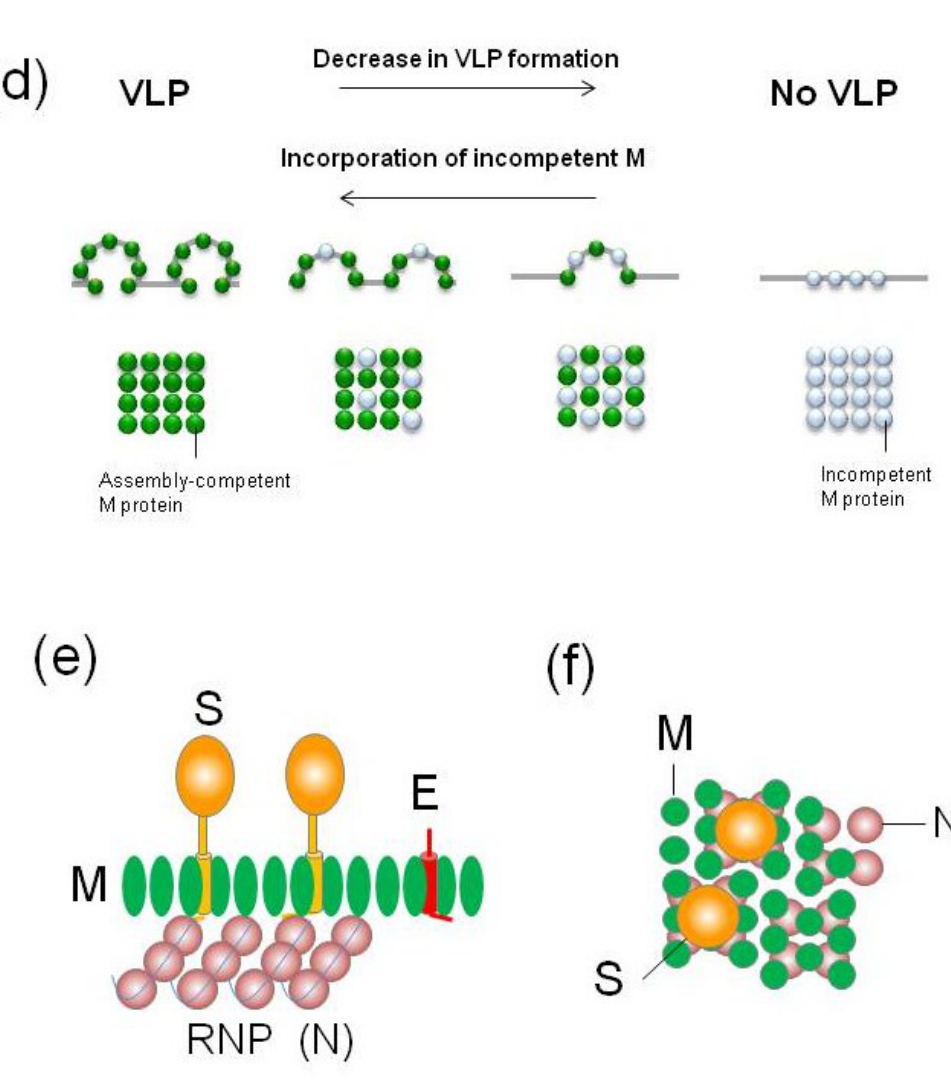
Figure 3. ( a ) Topology and schematic diagram of coronaviruses (CoV) M proteins. Three TM domains were assigned to tm1, tm2, and tm3 regions; ( b ) Trafficking signals of CoV-M proteins. Red box shows the identified intracellular retention signal, and the yellow box the plasma membrane targeting signal. The tm1 regions of SCoV- and infectious bronchitis virus (IBV), but not MHV-, M proteins are sufficient for intracellular retention (Top). Amino acid sequences of the tm1 regions of three CoV-M protein (Bottom). Conserved amino acids are shown in red. Asterisks indicate the uncharged polar residues critical for intracellular retention of VSV-G with tm1 regions of IBV-M [82]; ( c ) Minimum requirement for virus- like particle (VLP) formation. Coexpression of M and E proteins, but not M protein alone, resulted in formation of VLPs. E proteins might cause membrane bending or scission at the budding site. N protein likely assists VLP formation. In contrast, SCoV-M protein alone resulted in production of VLP, albeit at a low density. The minimum requirement for SCoV VLP assembly is controversial; ( d ) The importance of M-M interactions via multiple contact sites in the overall domain for VLP incorporation. Assembly-incompetent MHV-M proteins (light blue) lacking parts of the TM domain, the amphipathic domain, or the C -terminal